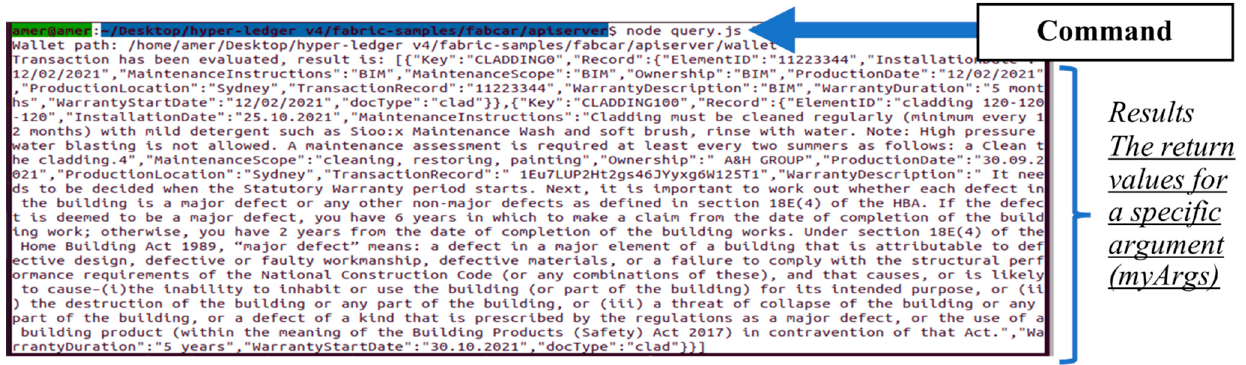
Figure 7. We successfully ran the queryID application and the return values for a specific argument, as shown in the Git console.